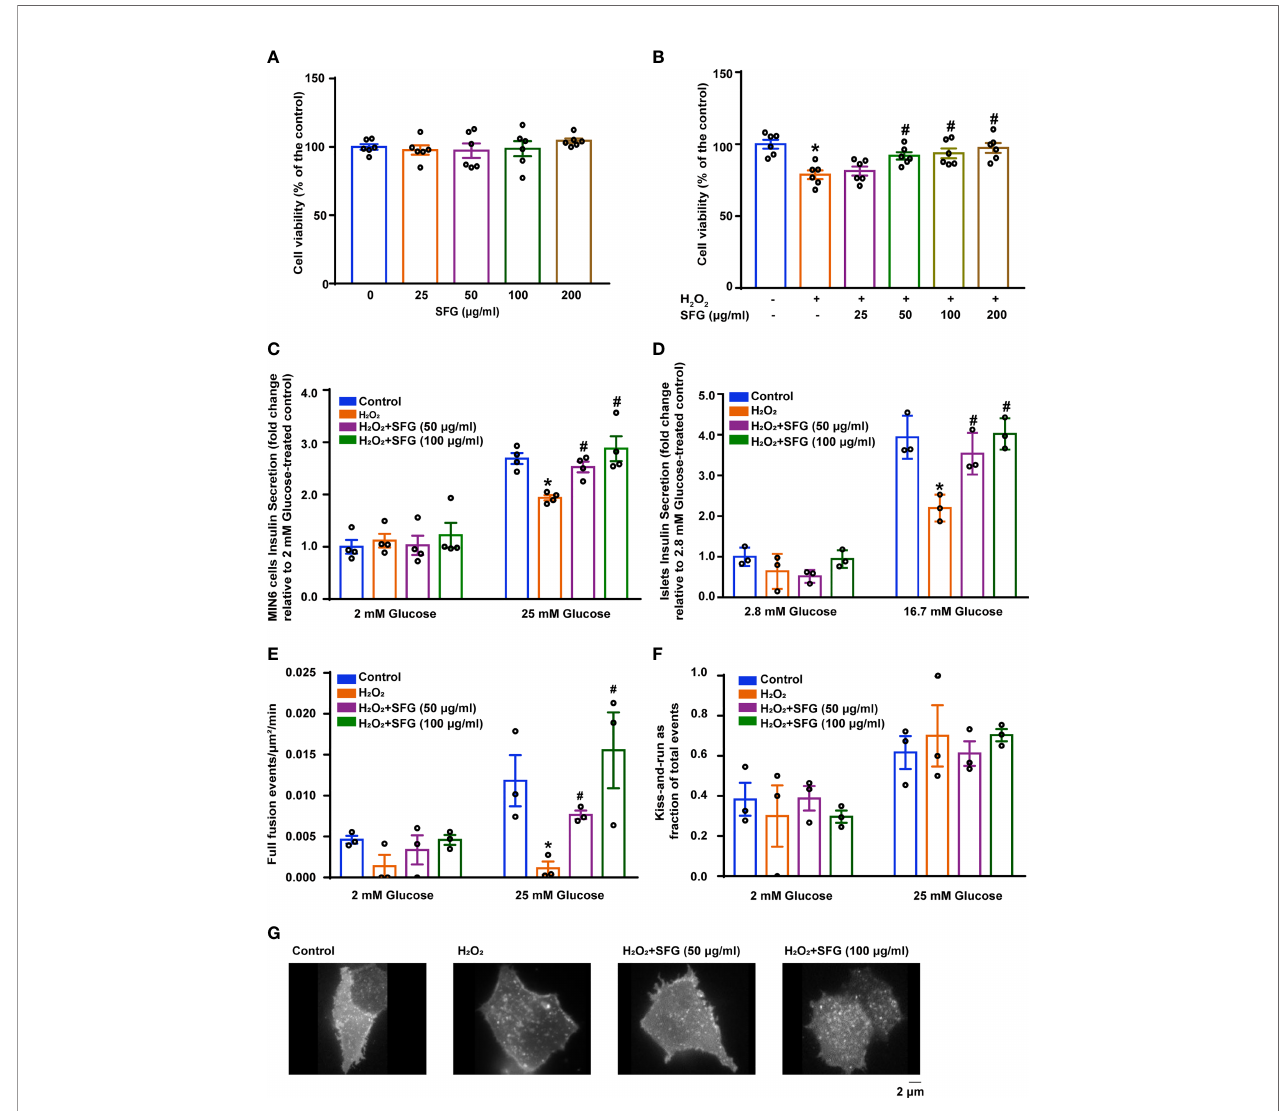
FIGURE 2 | SFG increased H 2 O 2 -treated b -cell viability and improved insulin secretion. (A) Viability of MIN6 cells after SFG treatment in the absence of H 2 O 2 exposure (n=6). (B) Viability of MIN6 cells exposed to H 2 O 2 before SFG treatment (n=6). *P < 0.05 versus control; # P < 0.05 versus H 2 O 2 -only group. (C) GSIS at 2 mM and 25 mM glucose in MIN6 cells (n=4). *P < 0.05 versus control; # P < 0.05 versus H 2 O 2 -only group. (D) GSIS at 2.8 mM and 16.7 mM glucose in islets (n=3). *P < 0.05 versus control; # P < 0.05 versus H 2 O 2 -only group. (E) SFG regulation of basal and glucose-stimulated insulin full fusion events. MIN6 cells transfected with VAMP2-pHluorin (n=3). *P < 0.05 versus control; # P < 0.05 versus H 2 O 2 -only group. (F) The fraction of kiss-and-run events relative to total fusion events was quanti fi ed under basal and glucose-stimulated conditions. MIN6 cells transfected with VAMP2-pHluorin (n=3). (G) Representative MIN6 cells under glucose-stimulated state were observed under